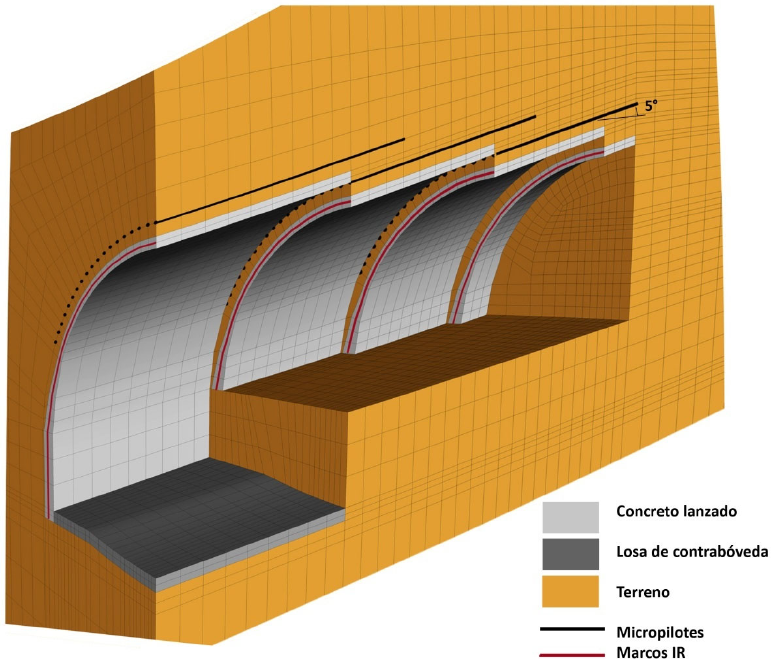
Figure 5. Finite difference mesh [12]. Definition terms: Concreto lanzado (sprayed concrete), Losa de contraboveda (tunnel floor), Micropilotes (micropile), Marcos IR (steel ribs).